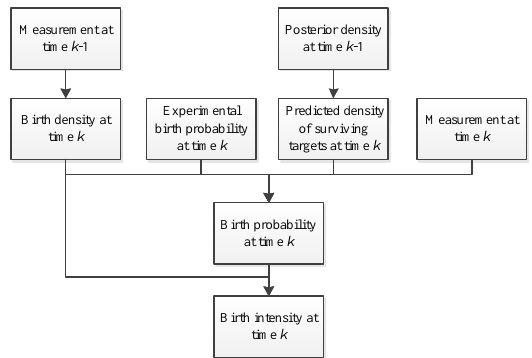
Figure 1. Modeling of the adaptive target birth intensity.